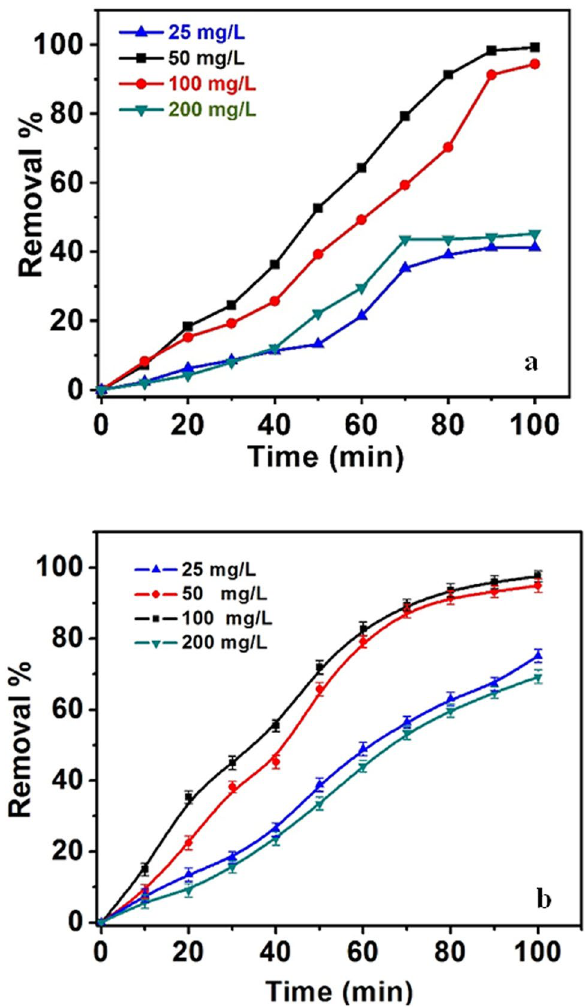
Figure 12. ( a ) Effect of CPA/N-SWCNTs-GO-CE/CuO nanospheres amount on the bleaching; ( b ) MO degradation, concentration of MO of 10 mg/L at pH 6.2 and time 100